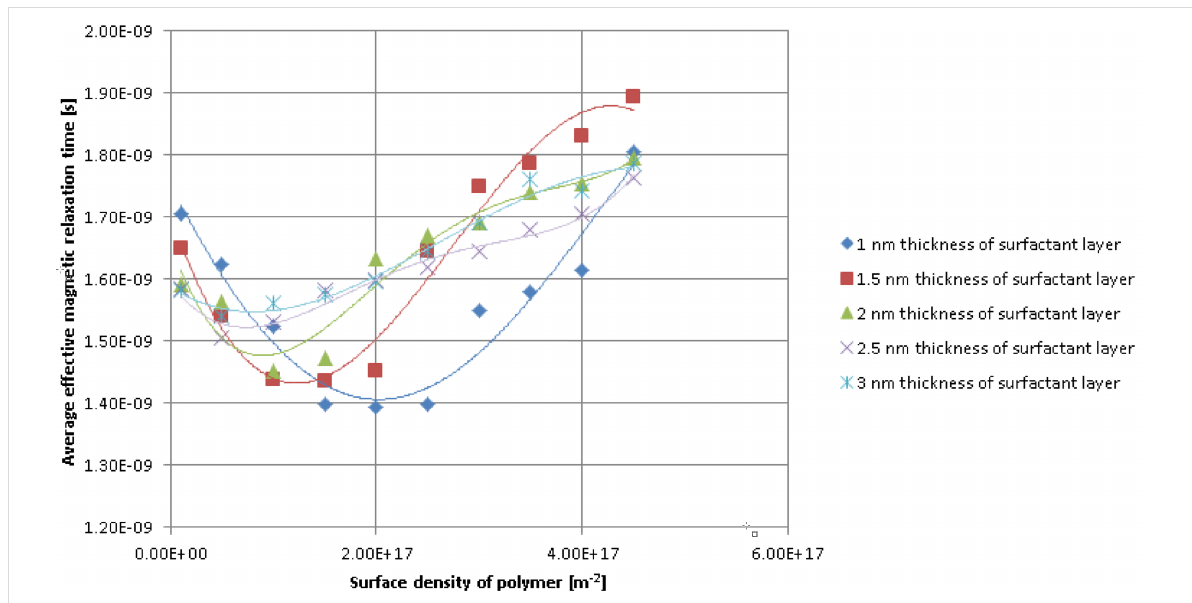
Figure 4: Average values of the effective magnetic relaxation time versus thickness of the nanoparticle coating layer, at high polymer surface density values.